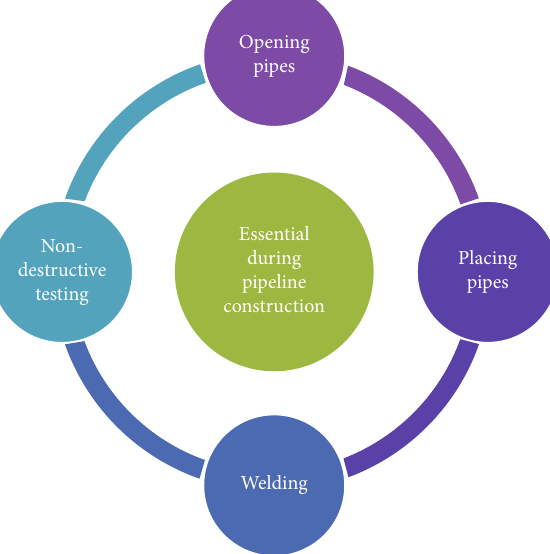
Figure 2: Essential during pipeline